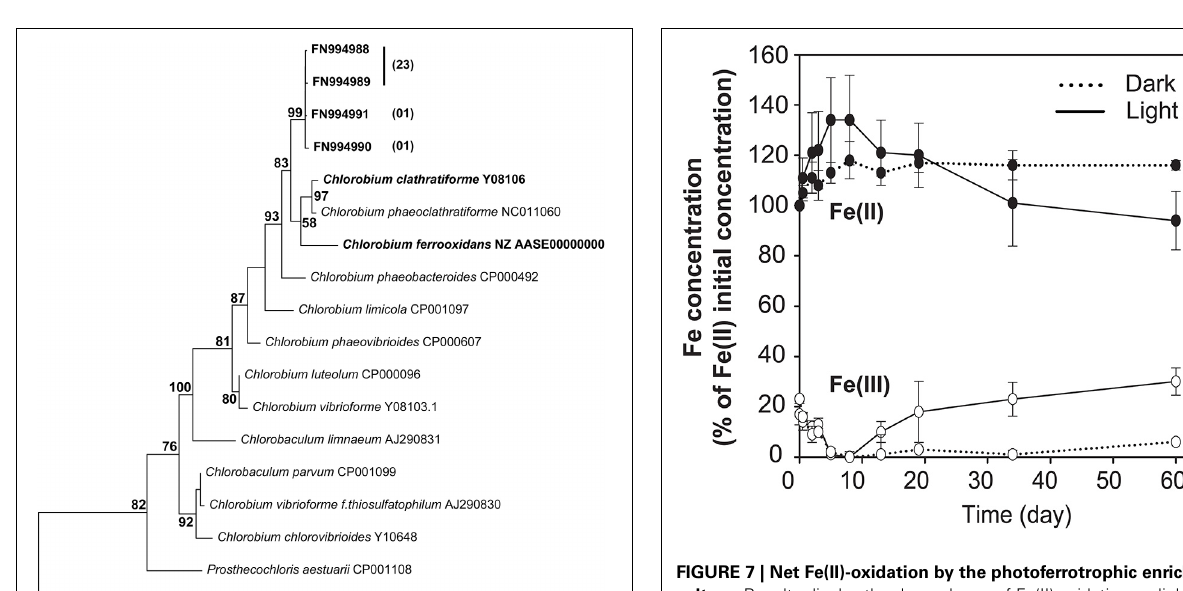
FIGURE 7 | Net Fe(II)-oxidation by the photoferrotrophic enrichment culture. Results display the dependence of Fe(II)-oxidation on light. Furthermore, Fe(III) added with the inoculum at the beginning of the experiment was reduced during the first 8h, presumably mediated by Acidobacteria, the second most abundant bacterial group in the enrichment culture. Data are average values of three independent experiments with error bars representing standard deviations ( n =